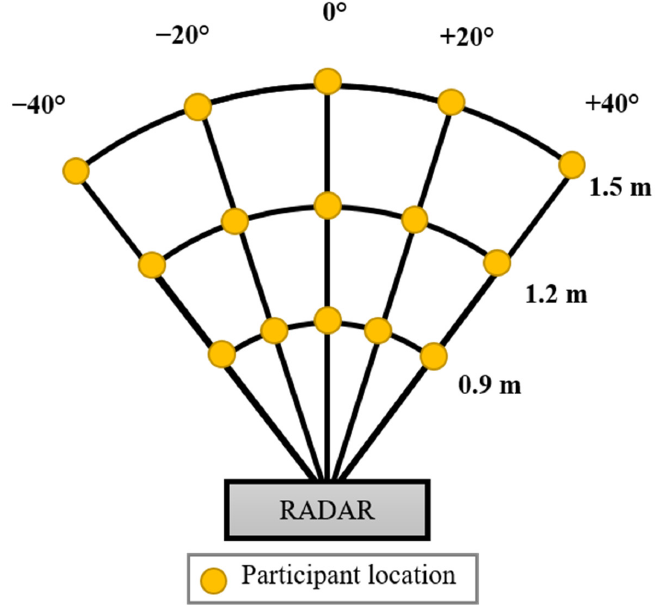
Figure 1. Designed experimentation to collect vital sign data at different distances and